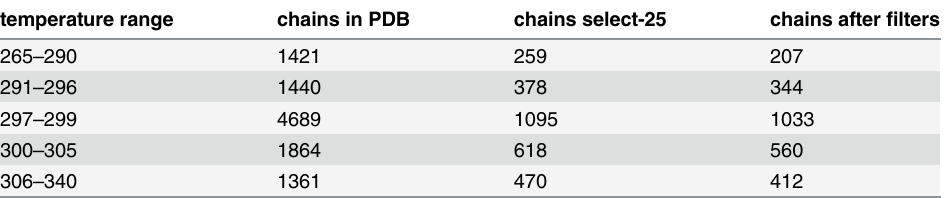
Table 1. Selected protein